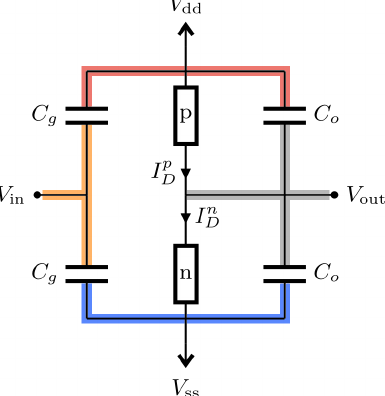
FIG. 9. A possible model of the CMOS inverter. The different conductors in the circuit (regions with the same potential) are identified with different colors (see Fig. 10).